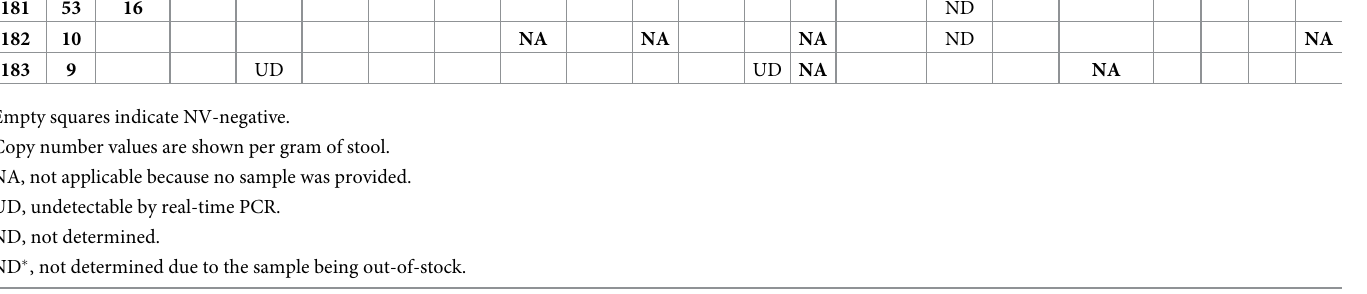
6 participants (ID13, 52, 55, 82, 83, 86) 2 times and 3 participants (ID11, 57, 101) 3 times. GII.8 infected participant ID59 2 times in F12 and F15. The ability of each genotype to infect the same individual multiple times appeared to largely correlate with the detection frequency shown in Fig